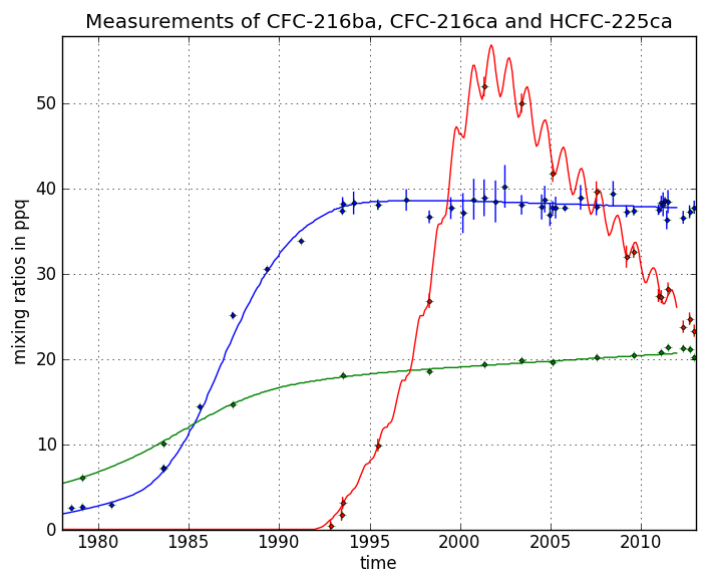
Figure 3. Mixing ratio time series for the Cape Grim samples for HCFC-225ca (red), CFC-216ba (blue) and CFC-216ca (green). Dots represent measured abundances with their respective 1 σ uncertainty estimates. Solid lines show the model fits used to determine the best fit emissions